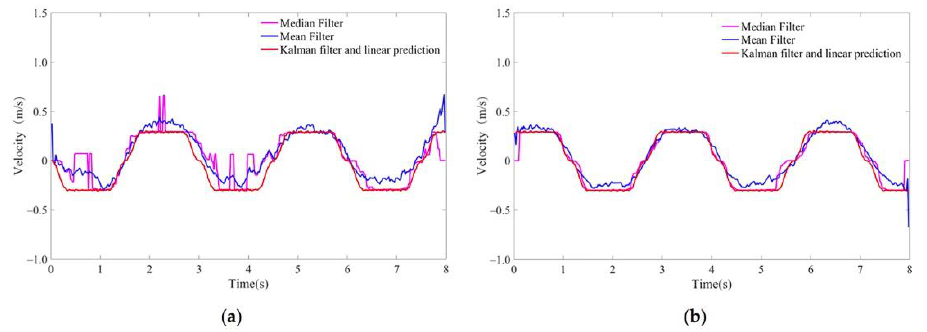
Figure 8. Velocity measured by CHDSF using the Kalman filter and linear prediction method, median filter and mean filter in different SNRs: ( a ) SNR = − 3.6 dB; ( b ) SNR = 7.7 dB. Table 4. Standard deviation of measured velocity by CHDSF and CHDSF using 3